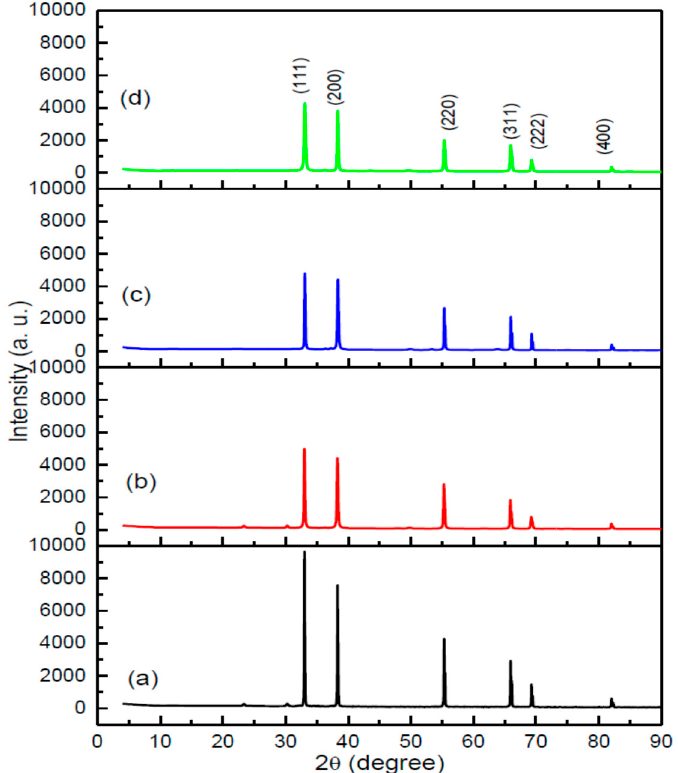
Figure 1. XRD patterns of as-prepared and calcined CdO nanoparticles at PVP different concentration of ( a ) 0.00; ( b ) 0.03; ( c ) 0.04 and ( d ) 0.05 g/mL. of ( a ) 0.00; ( b ) 0.03; ( c ) 0.04 and ( d ) 0.05